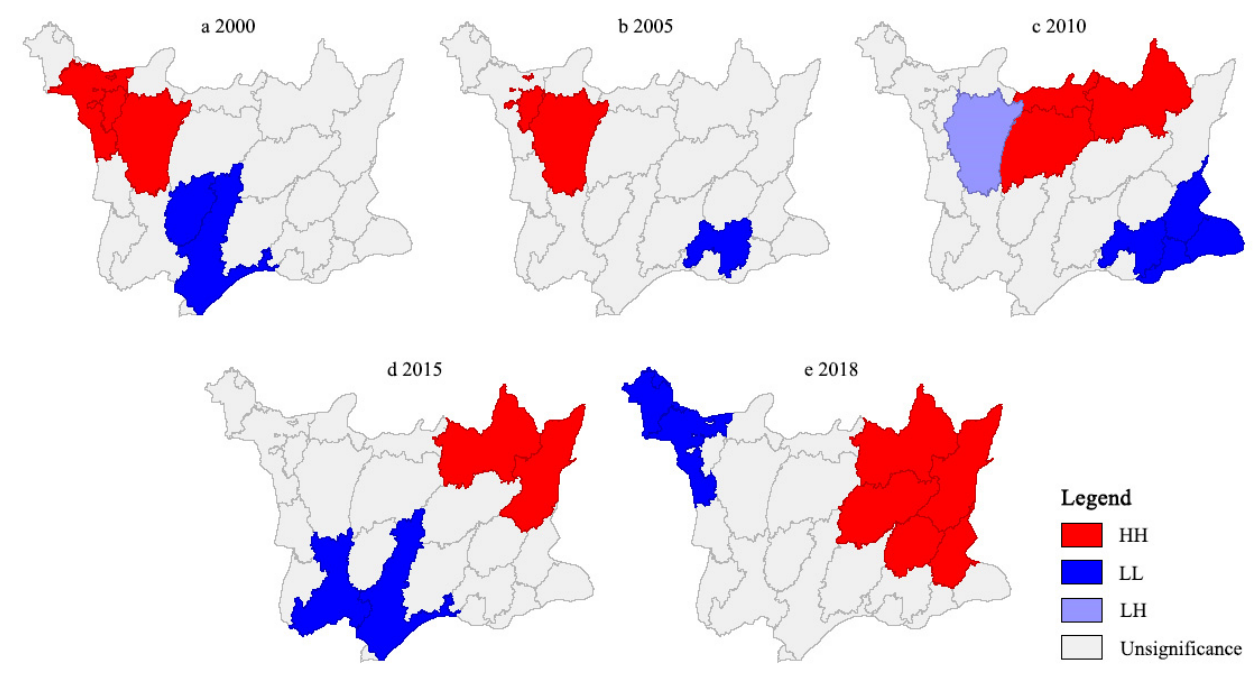
Figure 7. Local indicators of spatial autocorrelation (LISA) cluster maps of TESI in Huanggang Dabieshan UGGp from 2000 to 2018. HH, High-High agglomeration; LL, Low-Low agglomeration; LH, Low-High agglomeration.